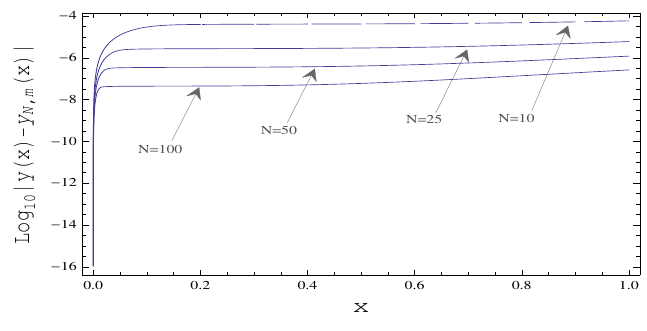
Figure 2. Absolute errors (in logarithmic scale) of approximations, for Example 1 with n = 1, m=10 iterations and N = 10 , 25 , 50 , 100.